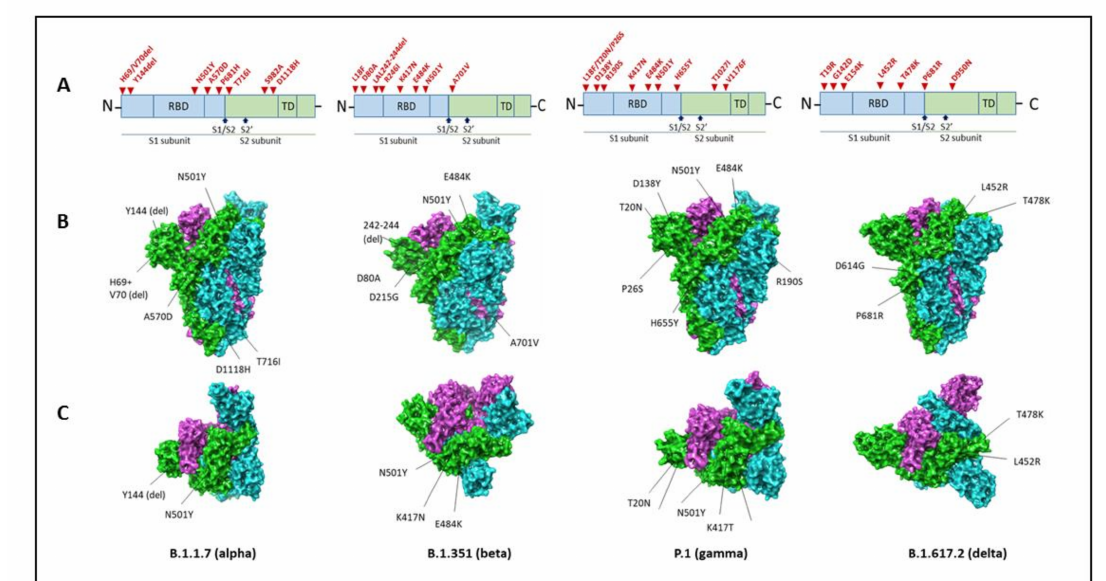
Figure 3. Spike mutations in the variants of concern. Amino acid substitutions and their locations in the Spike protein ( A ). The following PDB files are used for structural illustrations: 7LWV for B.1.1.7 (Alpha); 7LYN for B.1.351 (Beta); 7LWW for B.1.1.28.1 P.1 (Gamma); and 6ZGE for B.1.617.2 (Delta). Chain A: green, Chain B: blue, Chain C: purple. ( B ) Side view and ( C ) top view. The figures were prepared using Schrodinger software, and PDB files were obtained from protein databank (https://www.rcsb.org/, accessed on 9 September